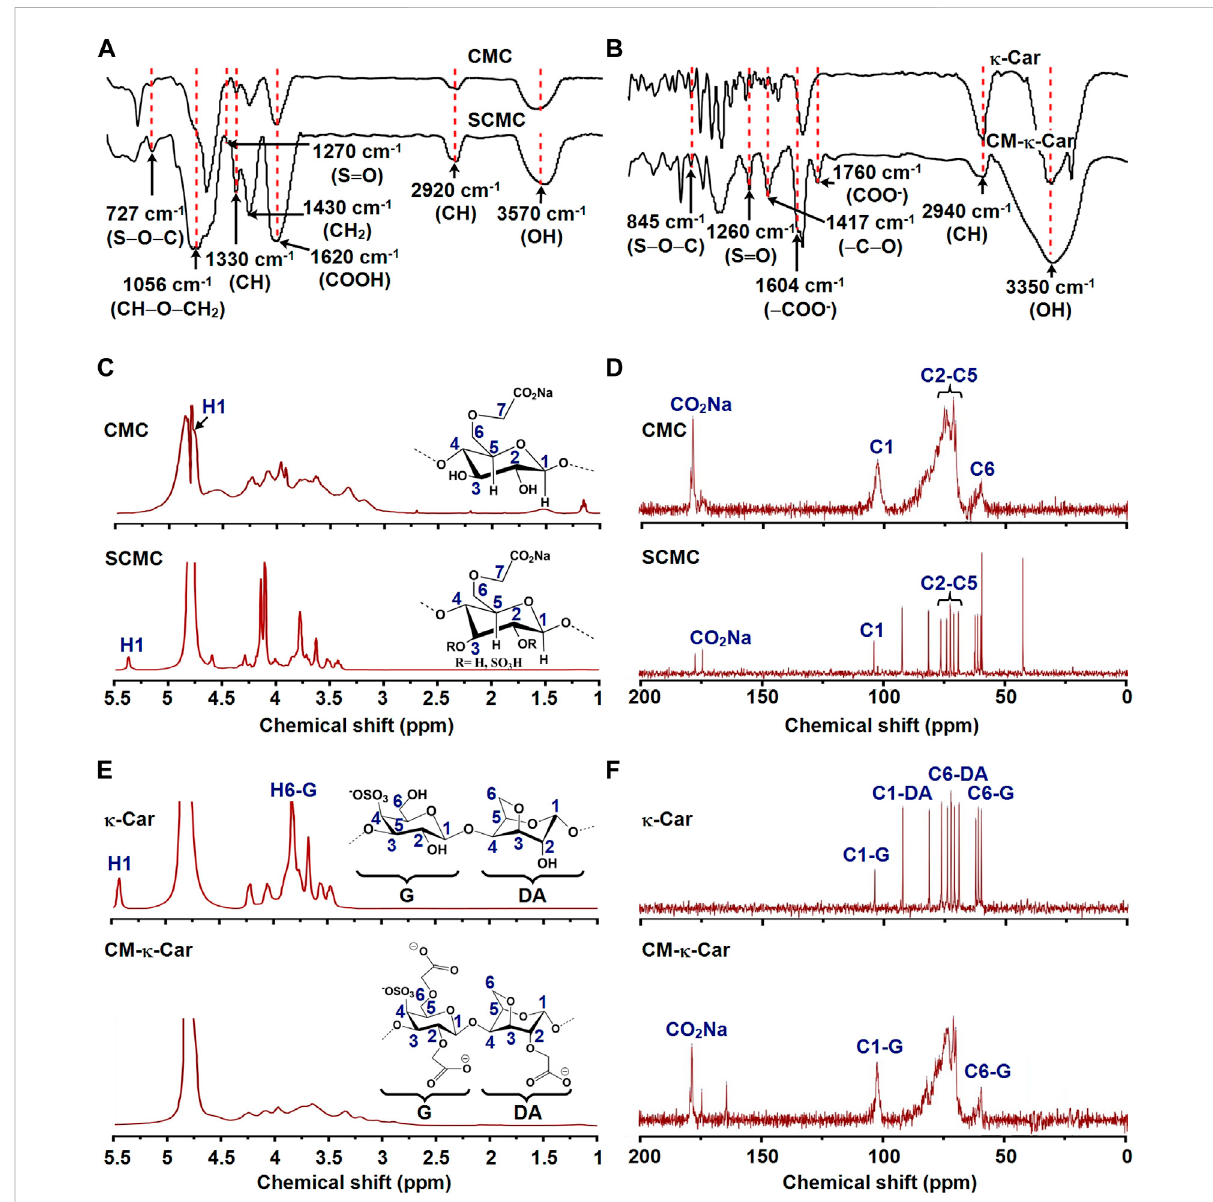
FIGURE 2 Effect of functionalization of CMC by sulfate groups and κ -Car by carboxymethyl groups on chemical composition and structure. (A) FTIR spectra of CMC and SCMC. (B) FTIR spectra of κ -Car and CM- κ -Car. FTIR, Fourier-transform infrared spectroscopy; CMC, carboxymethyl cellulose; SCMC, sulfated carboxymethyl cellulose; l -Car, κ -carrageenan; CM- l -Car, carboxymethyl κ -carrageenan. (C) 1 H NMR spectra of CMC and SCMC. (D) 13 C NMRspectra ofCMC and SCMC. (E) 1 HNMR spectra of κ -Car andCM- κ -Car. (F) 13 CNMR spectra of κ -Car andCM- κ -Car.NMR,Nuclear magnetic resonance; CMC, carboxymethyl cellulose; SCMC, sulfated carboxymethyl cellulose; l -Car, κ -carrageenan; CM- l -Car, carboxymethyl κ -